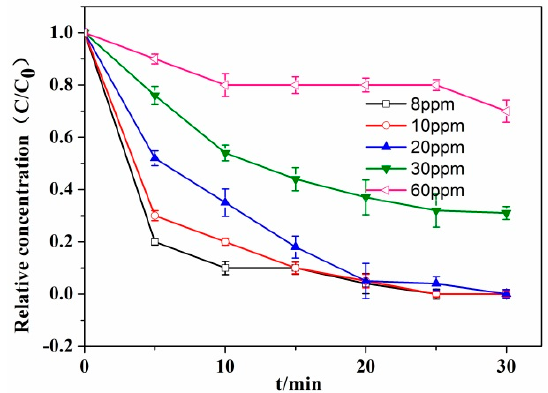
Figure 10. Influence of initial Cr(VI) concentration on its photocatalytic reduction by RCP-AG(15) under visible light with 40 µmol/L formic acid.